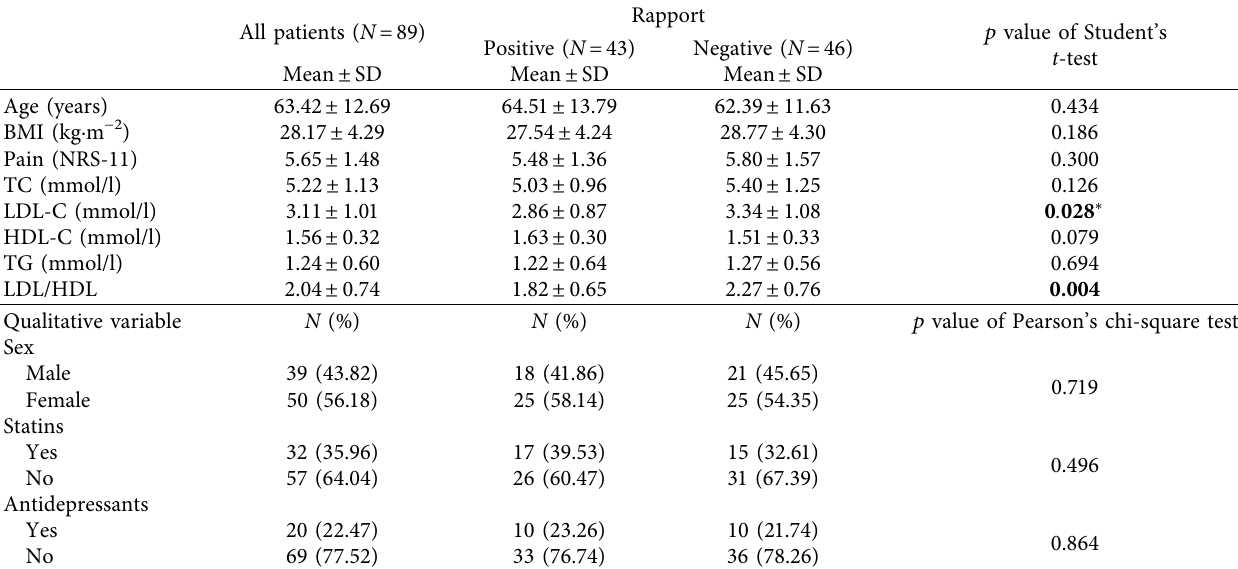
Table 1: Main characteristics of the